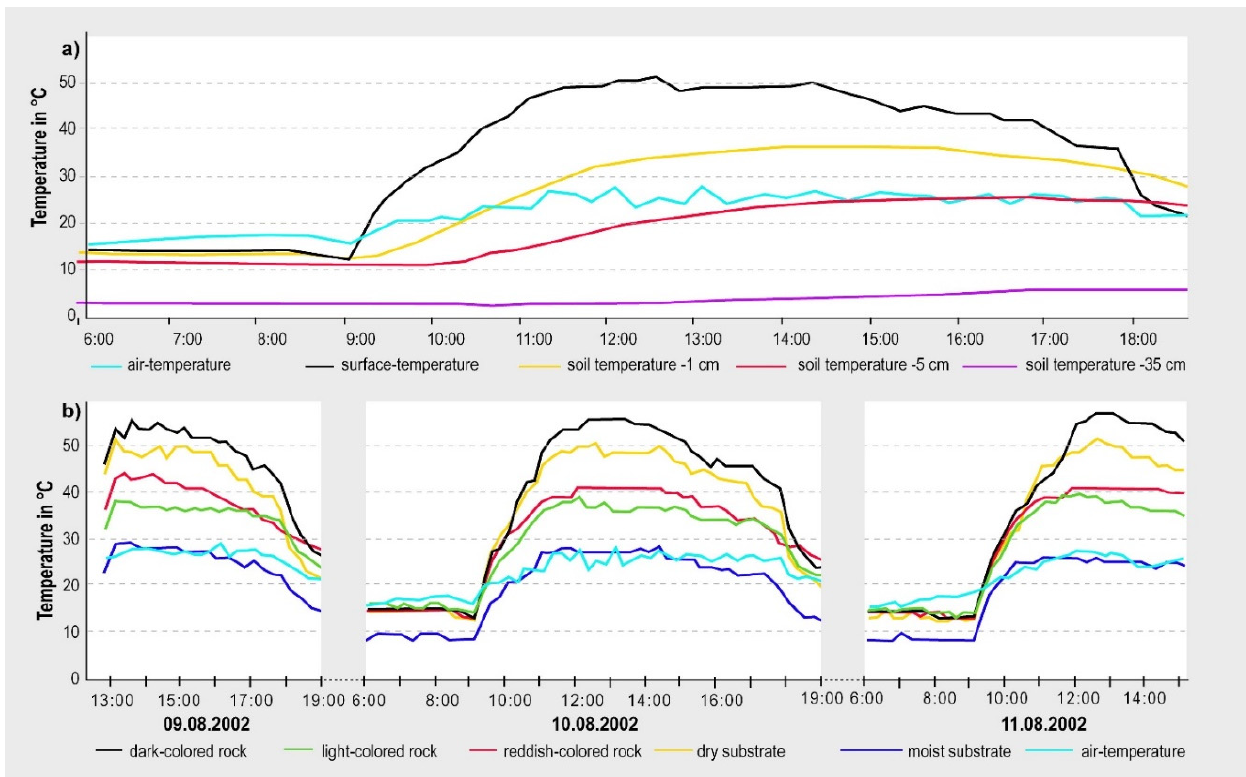
Figure 6. ( a ) Air temperatures (2 m), debris surface temperature and soil temperature at various depths, recorded on 10 August 2002 with cloudless skies on Carbon Glacier; ( b ) surface temperatures of differently colored debris together with air temperature recorded with cloudless skies on Carbon Glacier between 9 August and 11 August 2002 (redrawn and modified from [45])